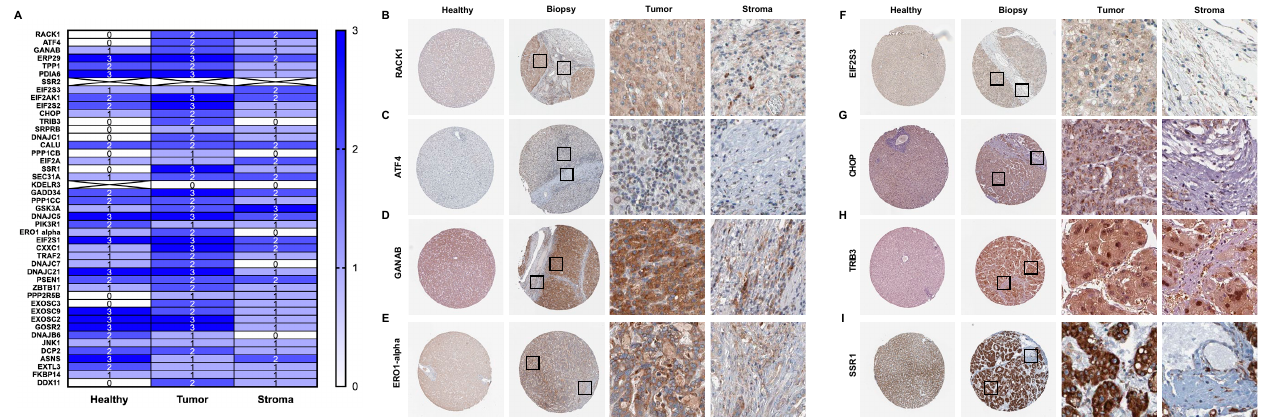
Figure 9. The histological scoring of healthy, stromal, and tumoral patient tissue stained against unfavorable UPR-associated markers ( A ). The selected markers are shown as individual images of healthy tissue and HCC biopsy ( B – I ).